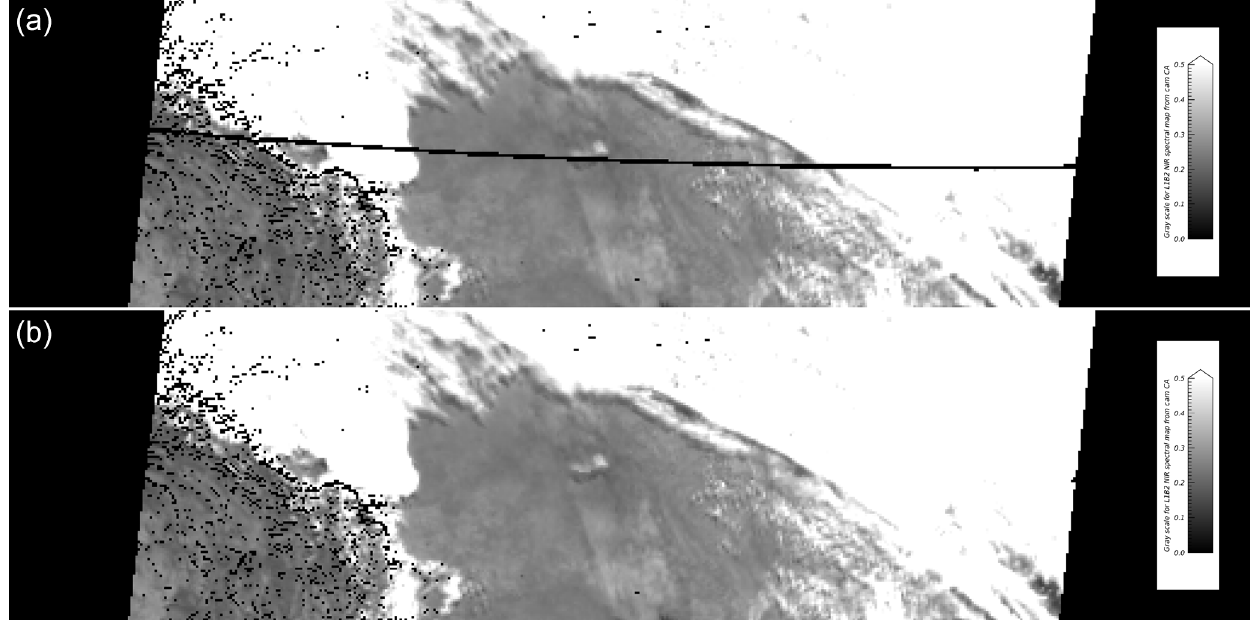
Figure 13. Maps of the GM-P168-O065487-B110-CA-NIR Brf data channel (a) before and (b) after replacing the missing and poor data values with the best estimates computed as described